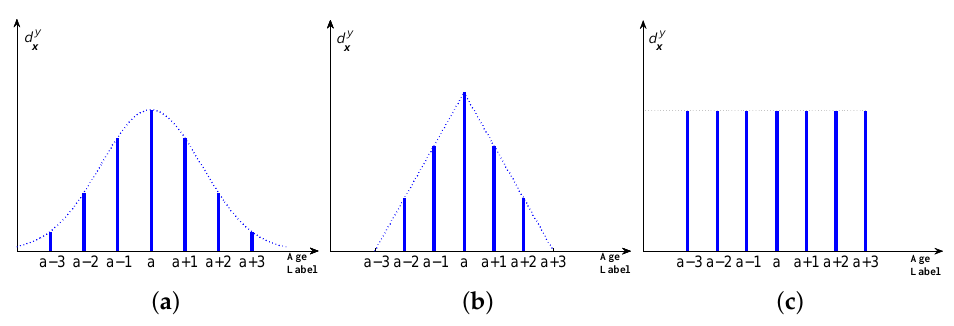
Figure 3. Two primary age label distributions ( a ) Gaussian-like distribution (with seven-class labels); ( b ) triangle distribution (with bottom length of six) and multiple age labels with same description degrees (with seven-class labels) ( c ) for the chronological age a